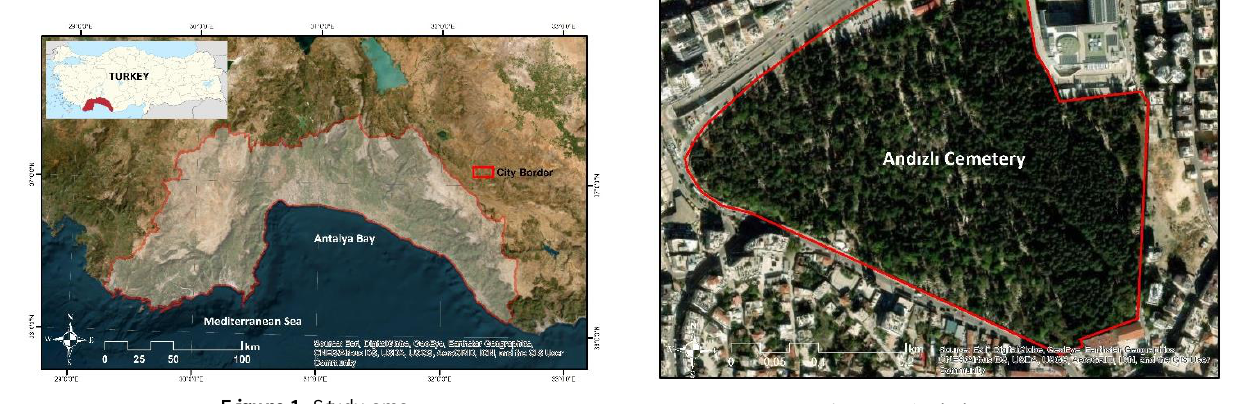
Figure 3 . Andızlı